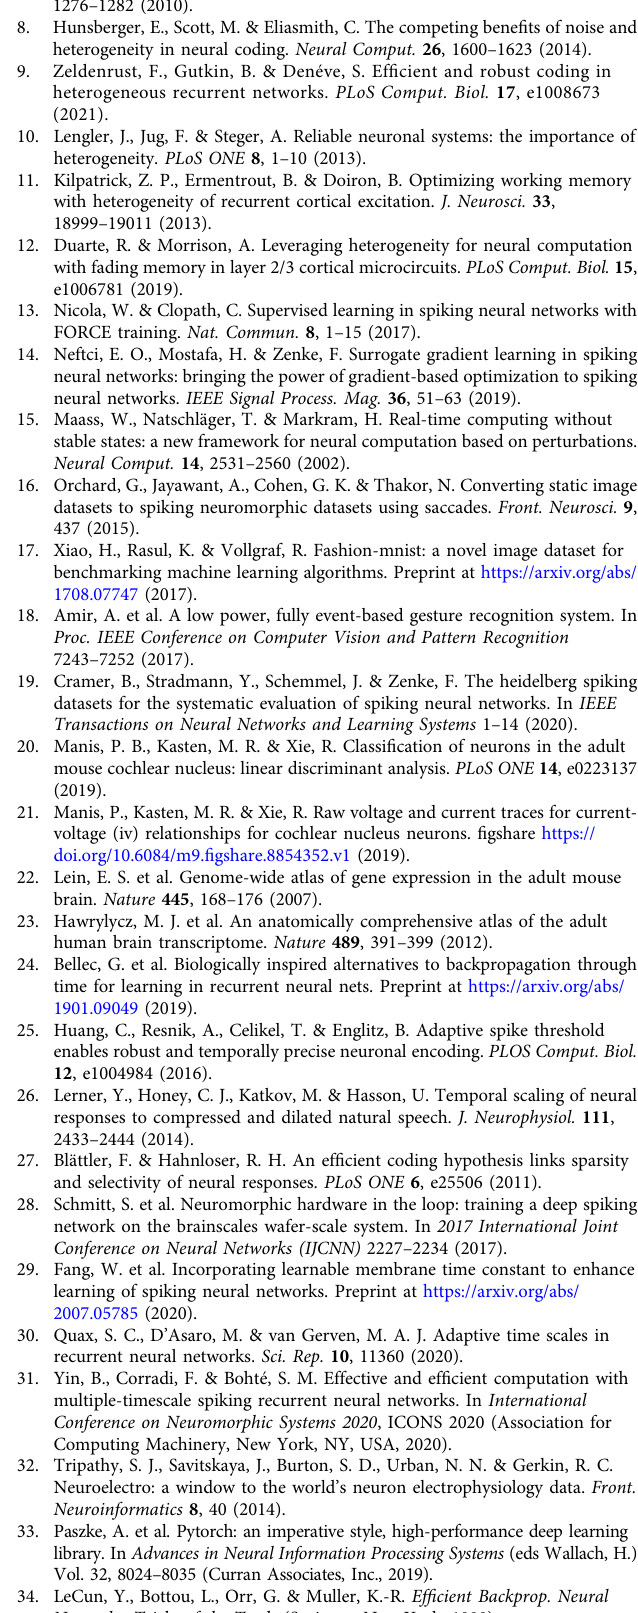
Table 4 FORCE network